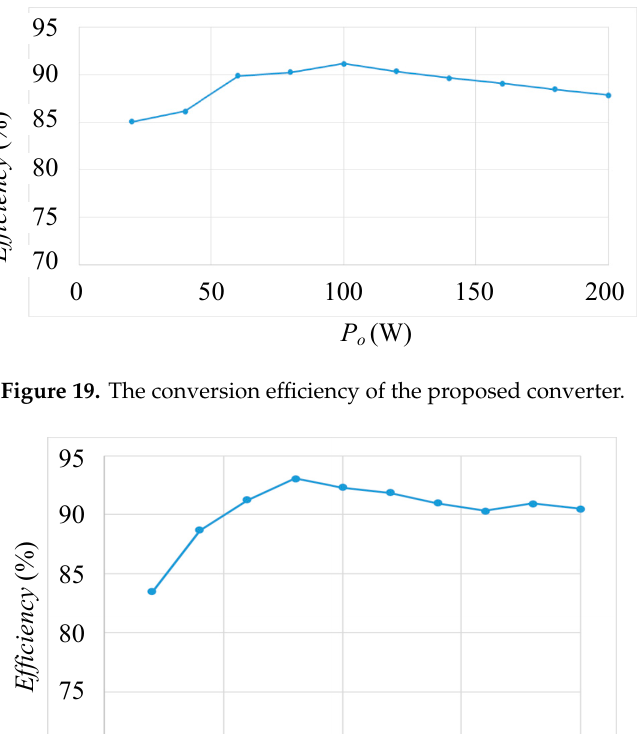
Figure 18. The practical measurement of output current I o .